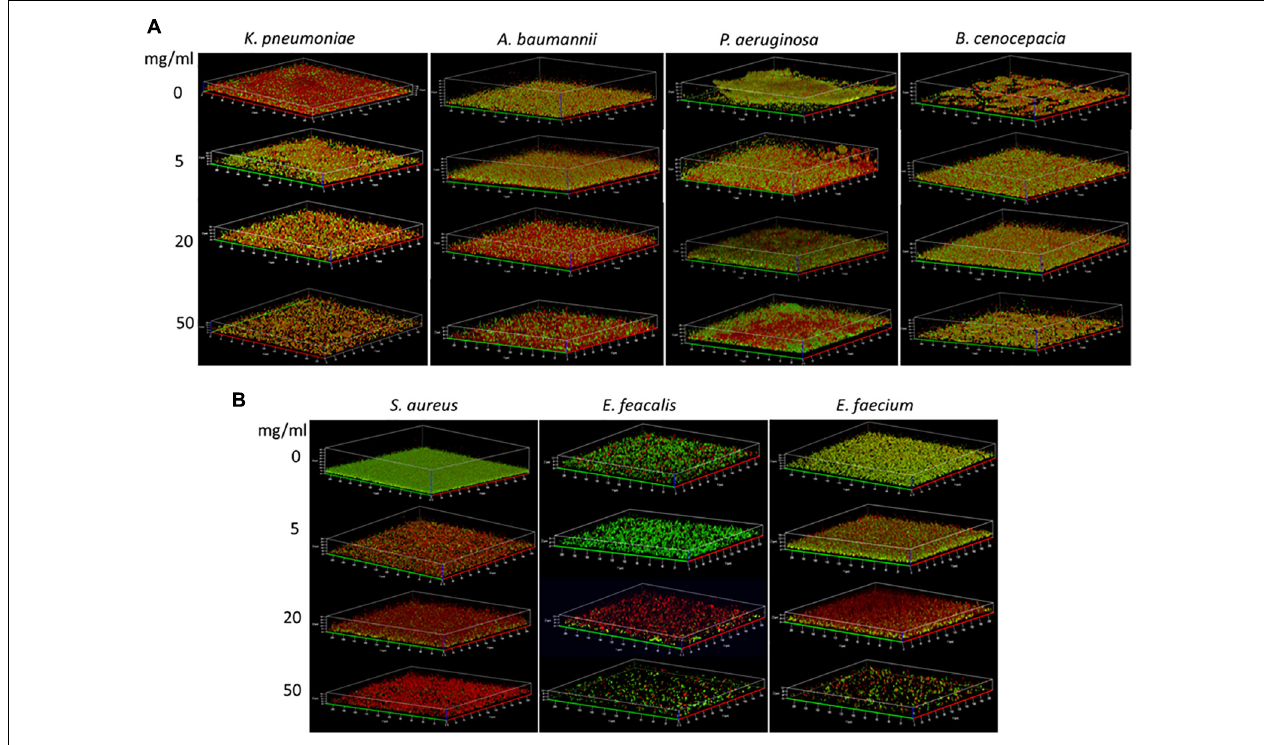
FIGURE 5 | Exemplary 3D images of the CLSM of untreated (0 mg/ml) and HMO-treated (5, 20, and 50 mg/ml) biofilms. (A) Gram-negative biofilms of K. pneumoniae ATCC 700603, A. baumannii IIMK450, P. aeruginosa PA 03, and B. cenocepacia BC 1. (B) Gram-positive biofilms of S. aureus ATCC 29213, E. faecalis ATCC 29212, and E. faecium Bk 013000. Sections of 212 µ m × 212 µ m (X/Y axes) were screened, and the Z -size varied depending on the biofilm thickness. Ticks on the Z -axis for K. pneumoniae indicate 4 µ m, and for the other strains 5 µ m. The biofilms were fluorescently stained by SYTO 9 (live, green) and propidium iodide (dead, red) before